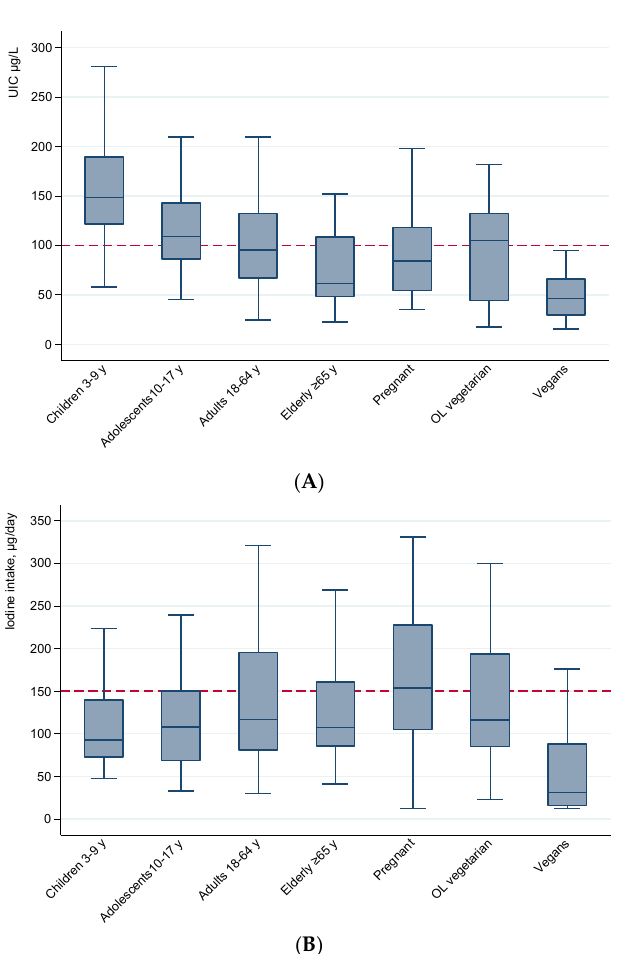
Figure 1. Urinary iodine concentration (UIC) μ g/L ( A ) and calculated iodine intake ( B ) by non ‐ overlapping subgroups defined by age, life stage and dietary practice. Box plot details: the horizontal lines indicate the median; the box indicates the interquartile range (IQR) (25th percentile to 75th percentile); the whiskers represent observations within 1.5 times the IQR. Outliers with values more than 1.5 times the IQR away from the box are not shown. The dashed line in A represents the WHO cut ‐ off for sufficient iodine intake in non ‐ pregnant groups. The corresponding cut ‐ off in pregnant women is 150 μ g/L. The dashed line in B represents recommended iodine intake in children >9 years, non ‐ pregnant adults and the elderly. Recommended intakes in the other groups are 90 μ g/day for children 2–5 years, 120 μ g/day for children 6–9 years, and 175 μ g/day for pregnant women [34].